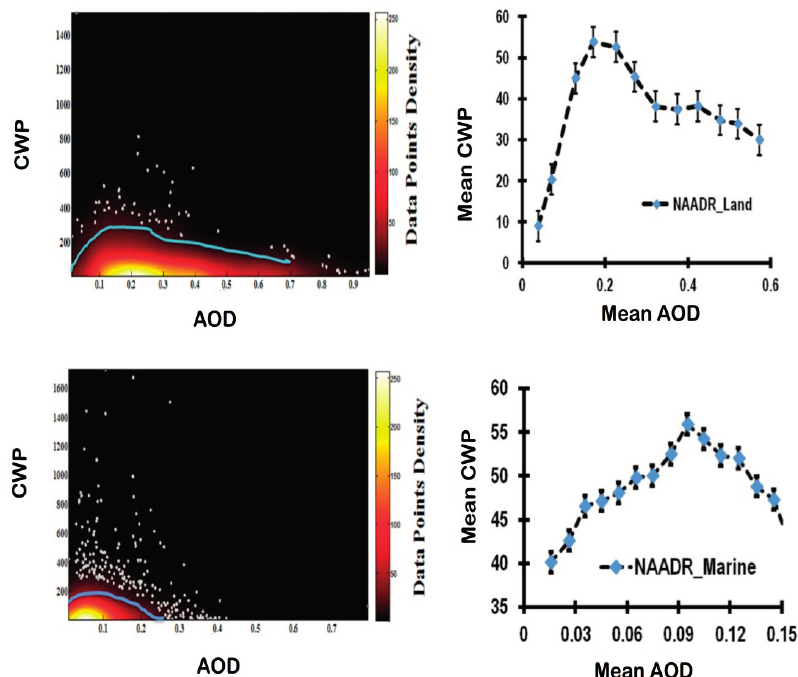
Figure 5. ( Top ) Shows for NAADR_Land the average behavior of cloud water path (CWP) to increasing aerosol optical depth (AOD) for all data density layers excluding outliers (White dots) ( Left ) and the plot of CWP vs. AOD after binning ( Right ). Each bin will have both an average and a standard deviation ( Bottom ) Shows for NAADR_Marine the average behavior of CWP to increasing AOD for all data density layers excluding outliers (White dots) (left) and the plot of CWP vs. AOD after binning (right). 3.3. Description of Cloud Water Path ( CWP ) Response to Increasing Aerosol Optical Depth ( AOD